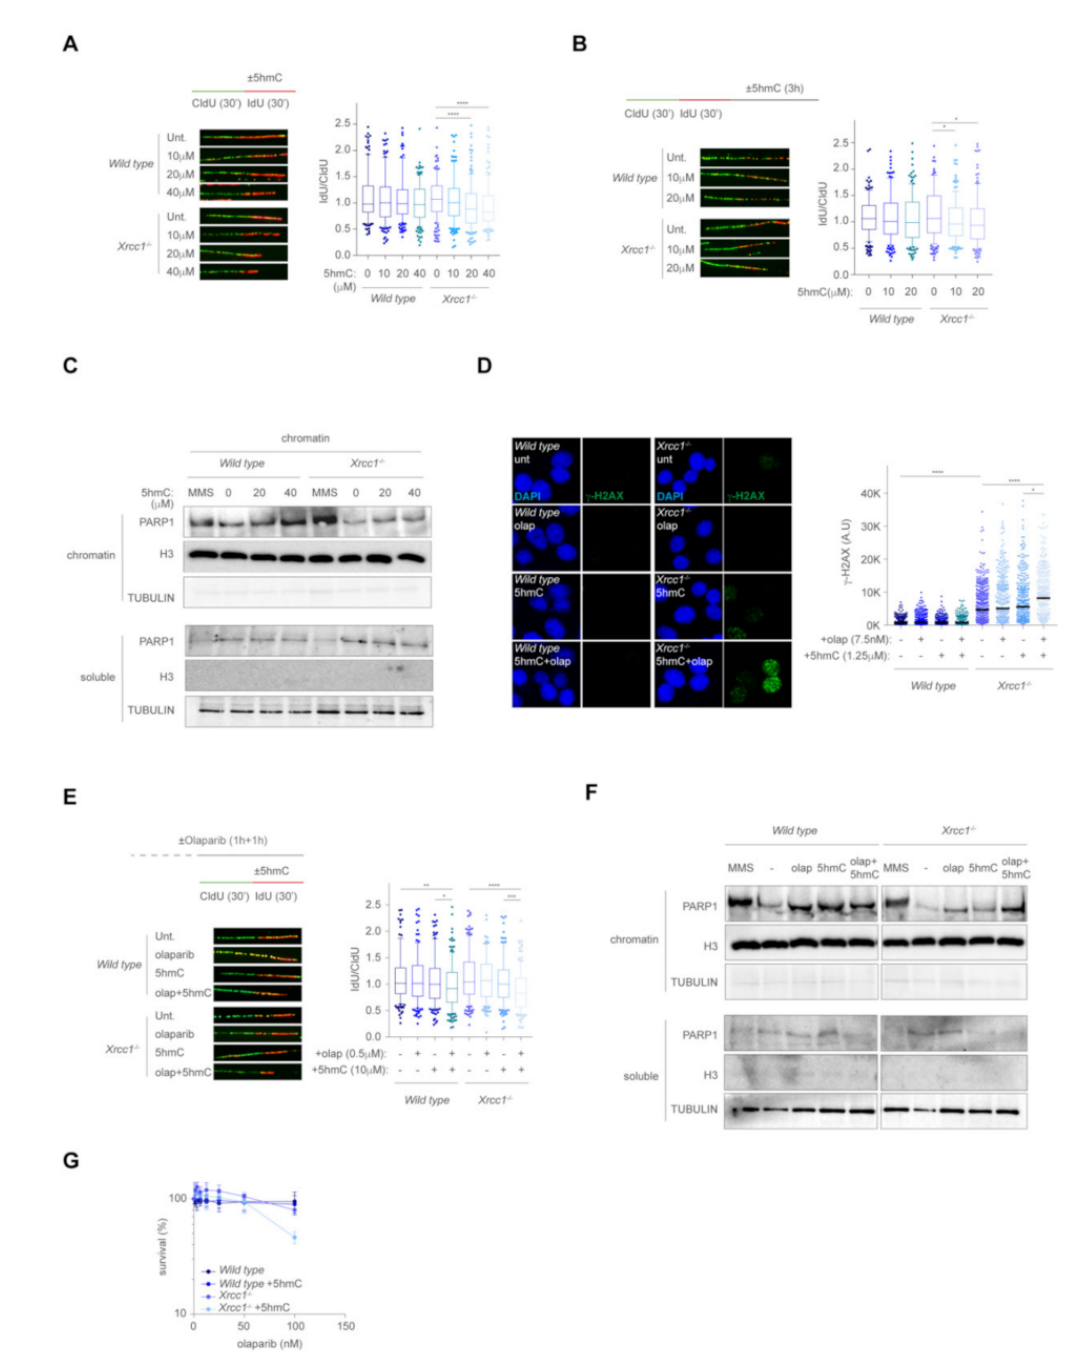
Figure 3. 5hmC induces replication fork instability, exacerbated upon PARP1 trapping by olaparib. ( A ) Top left, scheme of the DNA fiber assay. Bottom left, representative images of DNA fibers from wild type and Xrcc1 − / − MEFs after increasing doses of 5hmC (10 µ M, 20 µ M and 40 µ M) exposure. Right, box plot of the frequency of IdU/CldU ratios ( n = 150 of each of 2 biological replicates, Mann– Whitney test; box central line represents median and boxes include 10–90 percentile of data points). ( B ) Top left, scheme of DNA resection by the fiber assay. Bottom left, representative images of DNA fibers from wild type and Xrcc1 − / − MEFs after increasing doses of 5hmC (10 µ M, and 20 µ M) for 3 h upon IdU incorporation. Right, box plot of the frequency of IdU/CldU ratios ( n = 150 of each of 2 biological replicates, Mann–Whitney test; box central line represents median and boxes include 10–90 percentile of data points). ( C ) Western blot of PARP1, histone H3 and tubulin levels of chromatin and soluble-containing fractions from wild type and Xrcc1 − / − MEFs upon exposure to increasing doses